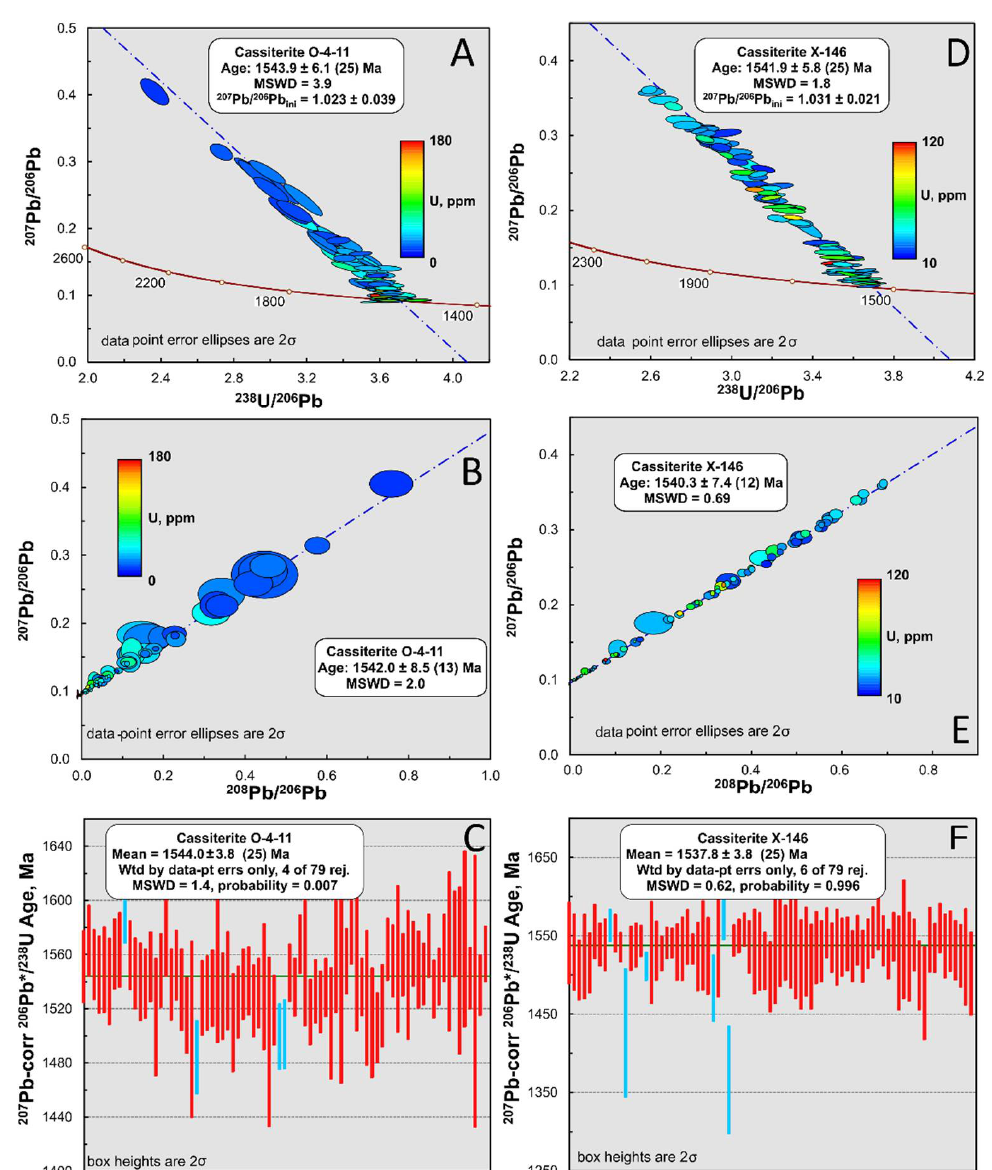
Figure 13. The U-Pb isotope data for cassiterite samples O-4-11 ( A – C ) and X-146 ( D – F ) from the Pitkäranta Mining District skarn deposits. Tera-Wasserburg isochron diagrams ( A , D ), inverse Pb-Pb isochrons ( B , E ) and weighted averages of the 207 Pb-corrected 206 Pb*/ 238 U ages ( C , F ) are also shown. The vertical lines in ( C , F ) represent age values with 2 standard error (2 SE) bars. The blue lines are outliers not included in the weighted average calculation.